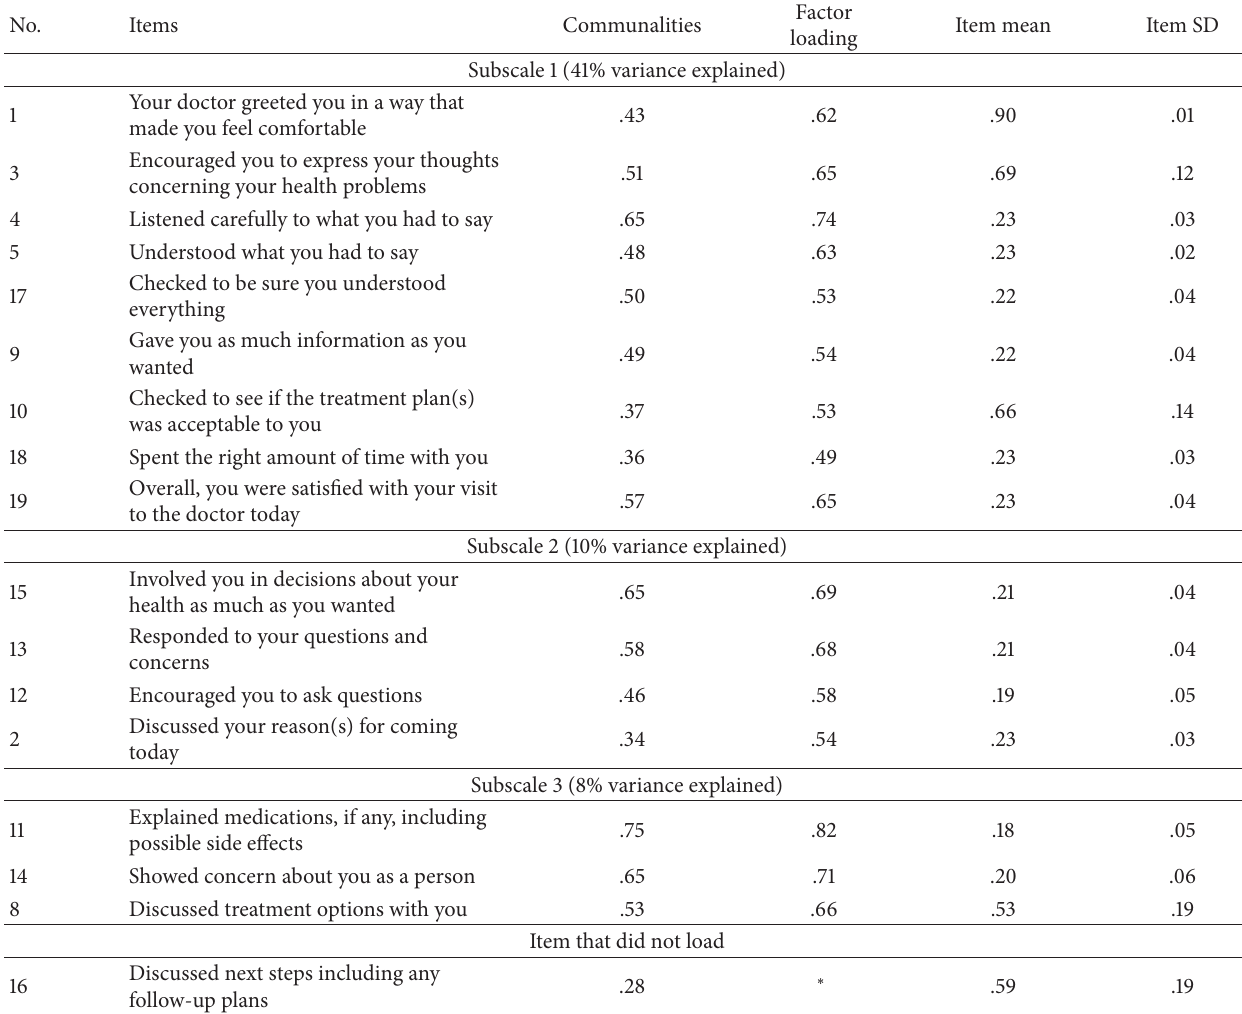
Table 2: Factor loading of the PPCB